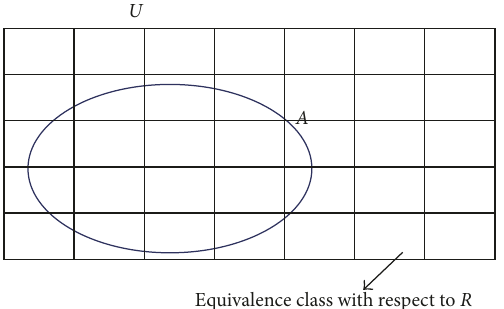
Figure 1: A universe 𝑈 partitioned by an equivalence relation 𝑅 and a concept 𝐴 ⊆ 𝑈 that cannot be defined using 𝑅 [41,